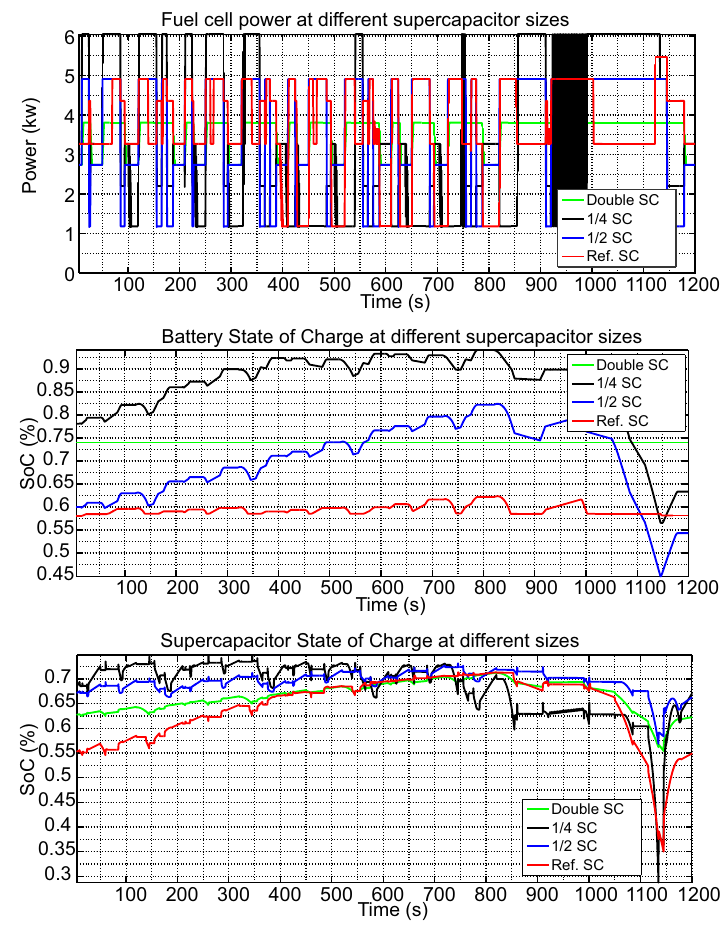
Figure 23. Effect of optimization parameters at different supercapacitor sizes